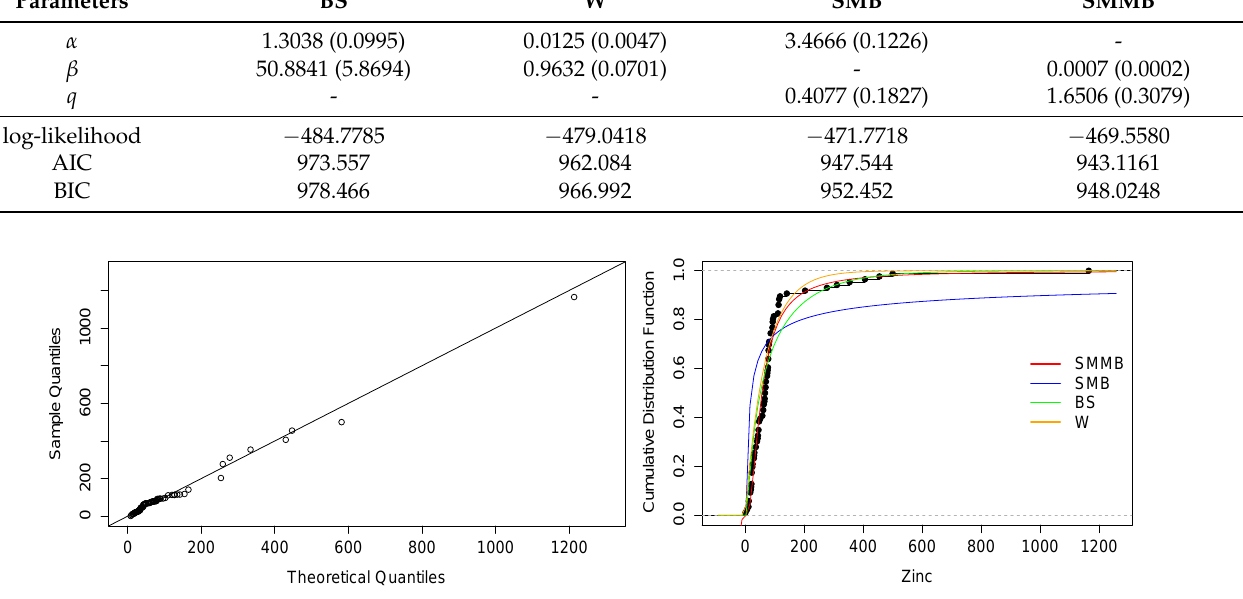
Figure 6. ( Left panel ): qq-plot for zinc data set versus the fitted SMMB distribution. ( Right panel ): Empirical cdf (black) and estimated cdf of SMMB (red), SMB (blue), BS (green) and W (orange) models for the zinc data